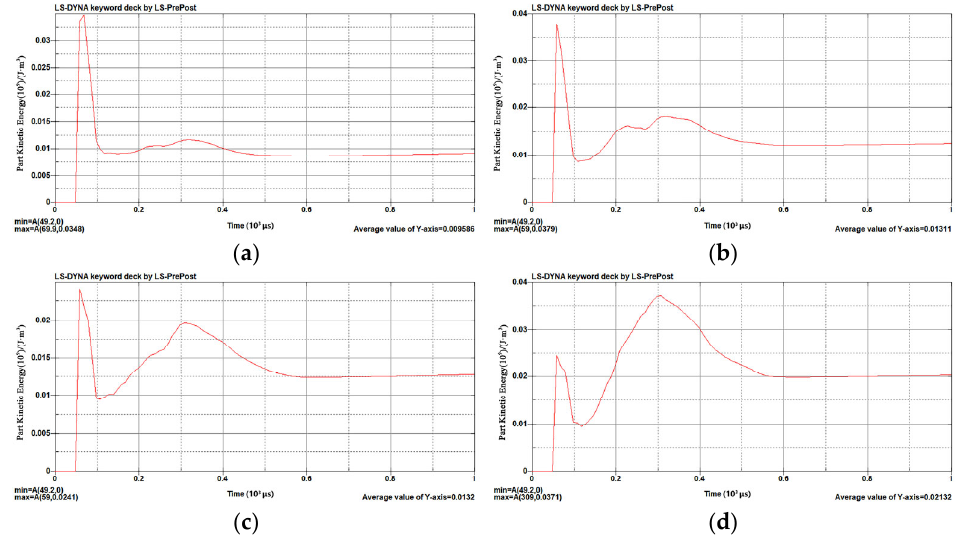
Figure 7. ( a ) Blasting with 3.2 kg TNT; ( b ) blasting with 4.8 kg TNT; ( c ) blasting with 6.4 kg TNT; ( d ) blasting with 8.0 kg TNT.